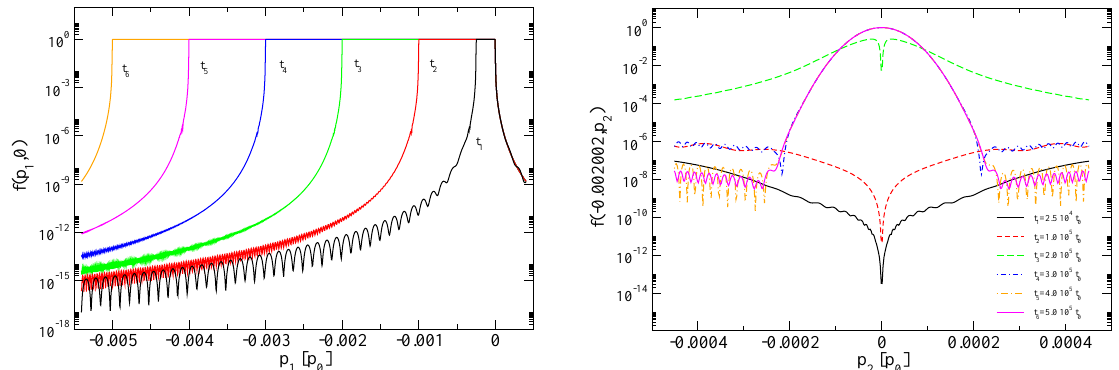
Figure 11. The distribution function in momentum space for the range of time: t 1 = 2.5 × 10 4 t 0 ( 6.15 × 10 − 12 s), t 2 = 1 × 10 5 t 0 ( 2.46 × 10 − 11 s), t 3 = 2 × 10 5 t 0 ( 4.92 × 10 − 11 s), t 4 = 3 × 10 5 t 0 ( 7.38 × 10 − 11 s), t 5 = 4 × 10 5 t 0 ( 9.84 × 10 − 11 s), t 6 = 5 × 10 5 t 0 ( 1.23 × 10 − 10 s). The electric field strength E a = 1 × 10 − 8 E 0 ( 1.088 V/cm). The dependence of the distribution function on p 1 for p 2 = 0 is shown on the left panel while the dependence on p 2 for p 1 = − 0.002002 p 0 is shown on the right panel.